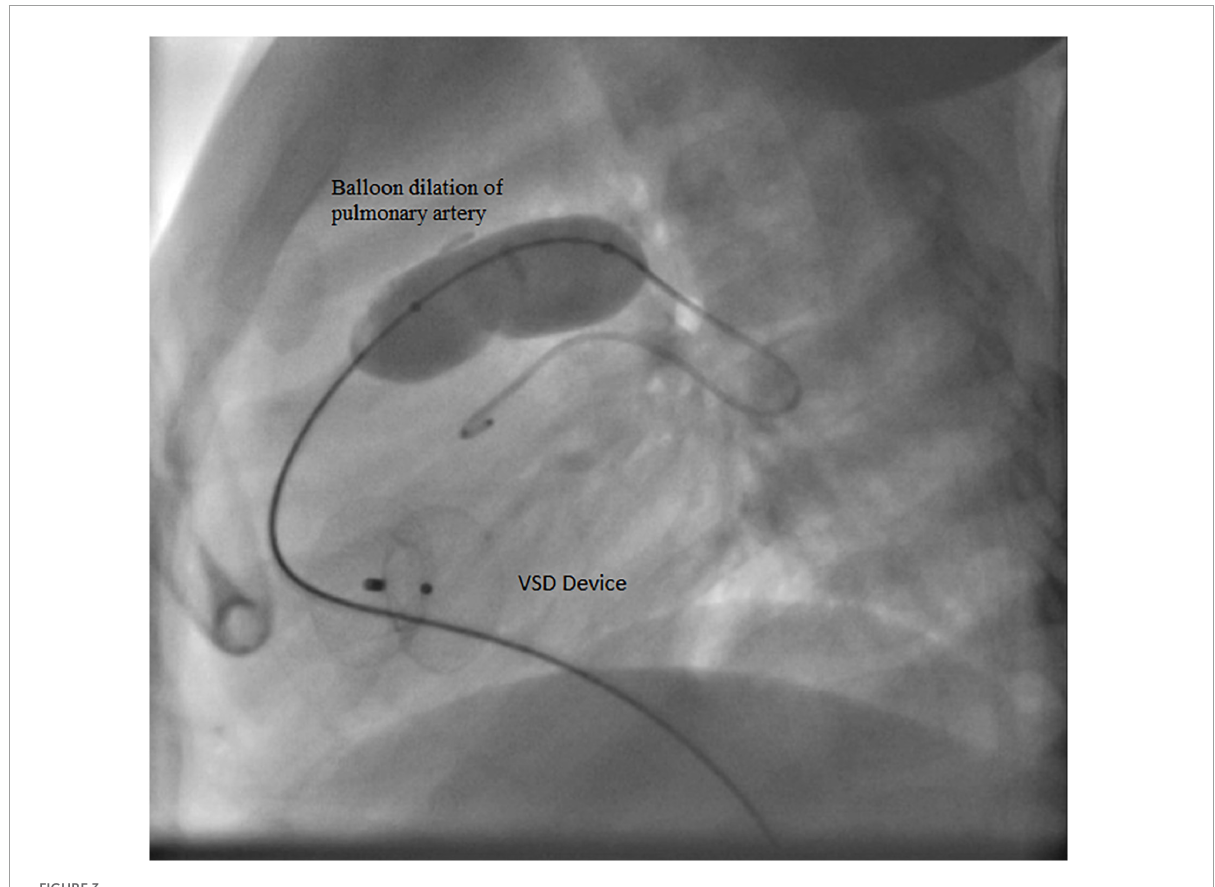
FIGURE3 Balloon dilation of the pulmonary artery of Case